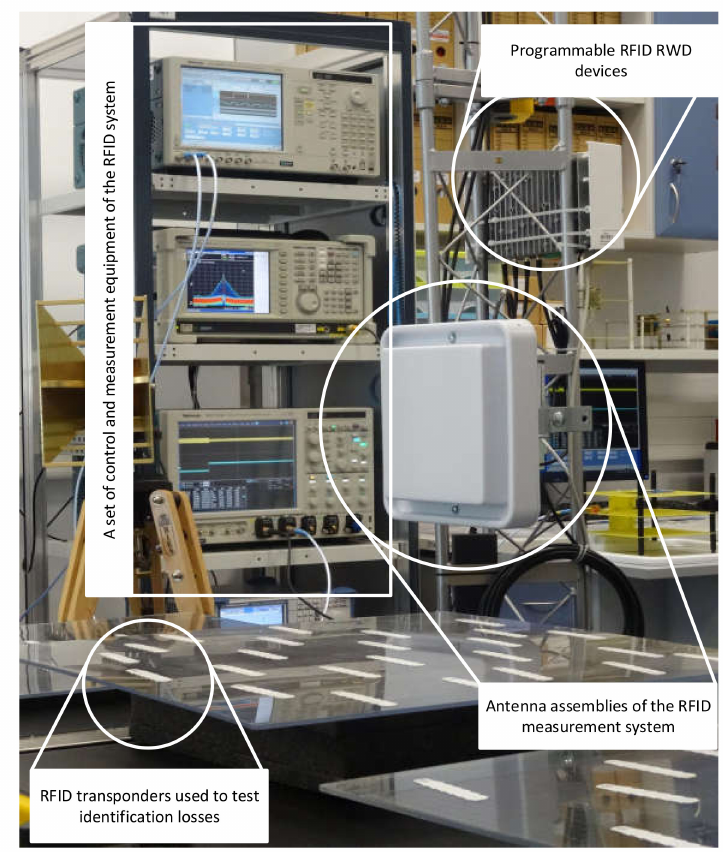
Figure 18. Laboratory tests of dynamic identification with multiple RFID transponders.